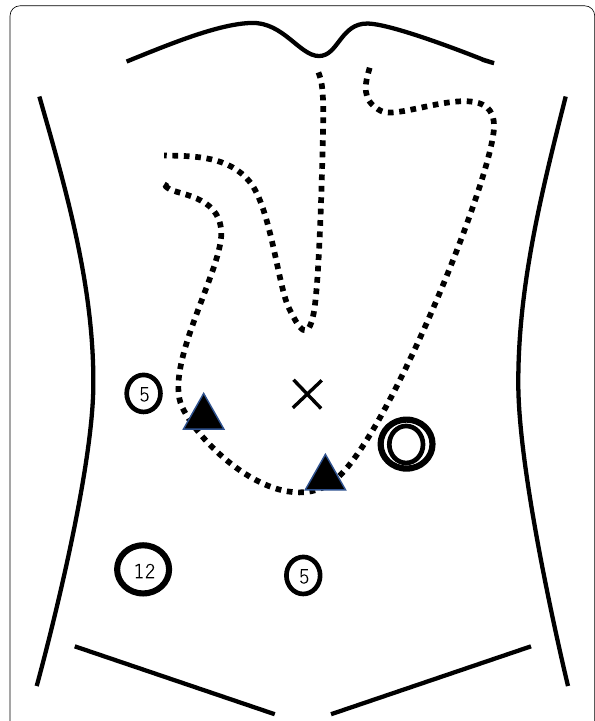
Fig. 3 The stomach (a dotted line) was fixed to the abdominal wall. Two black triangles point to the suture sites. A double circle, single circles and numbers point to the sigmoid colostomy, the location and size of the trocars, respectively